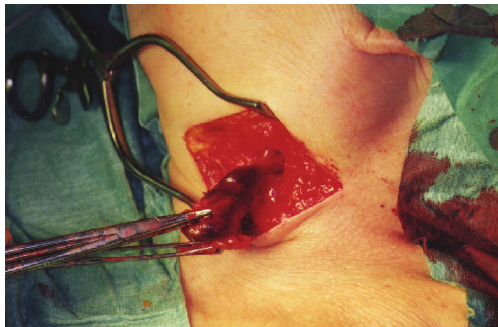
Figure 2: The jugular vein is twisted as the aneurysm is pulled up before